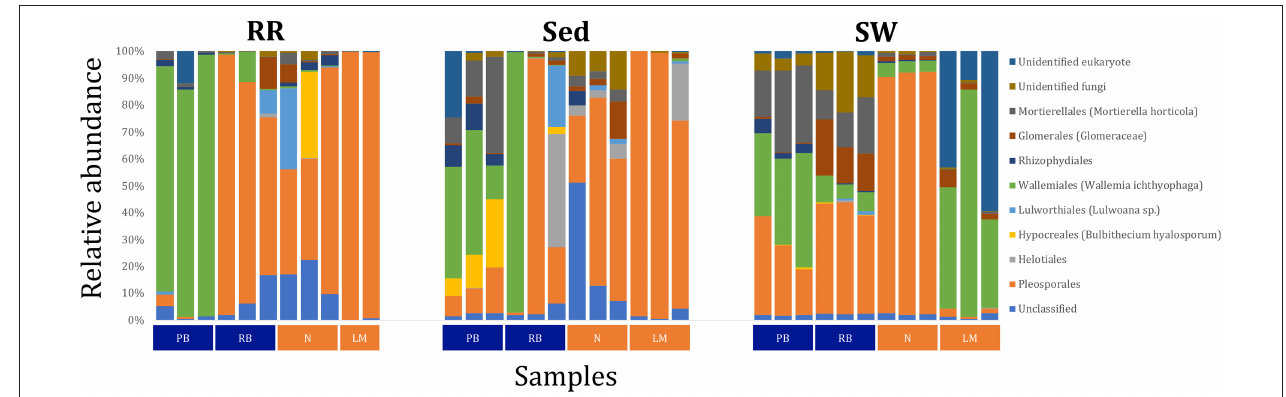
FIGURE 11 | Fungal community composition across seagrass microenvironments. Beta diversity of fungal microbiomes across the three seagrass microenvironments studied here. Triplicate samples per microenvironment within each of the four sampling sites ( n = 35) are colored by the highest assigned taxonomic level. Unique OTUs were summarized at the species level, and the representation of taxonomic groups within each sample are plotted. Only representative species with a relative abundance > 1% in all samples are shown to help remove visual clutter. RR, roots and rhizomes; Sed, sediment; SW, seawater; PB, Palm Beach; RB, Rose Bay; N, Narrabeen Lagoon; LM, Lake Macquarie.